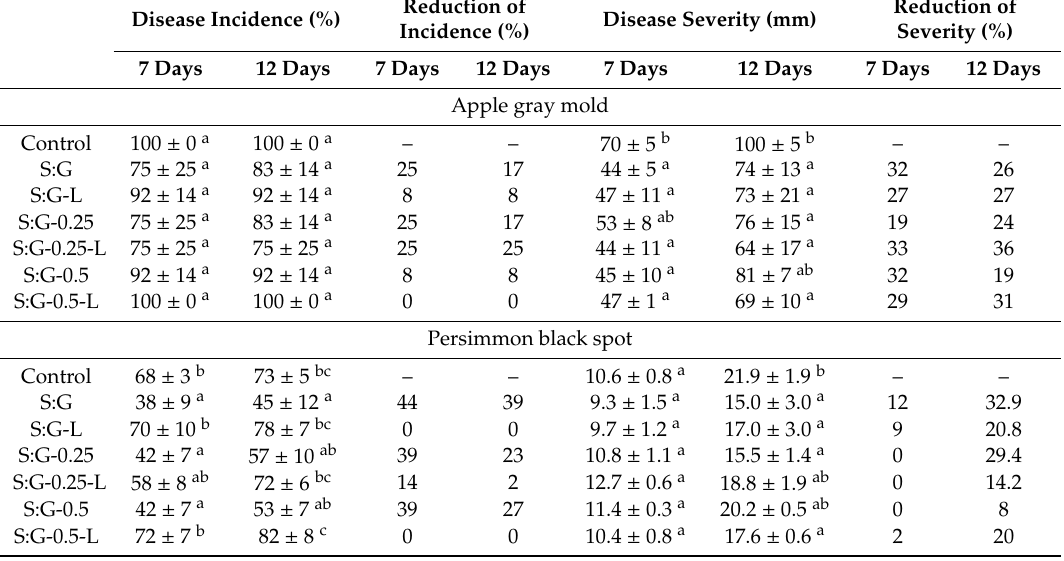
Table 5. Mean values and standard deviations of disease incidence and severity of gray mold on ‘Golden Delicious’ apples artificially inoculated with Botrytis cinerea and black spot on ‘Rojo Brillante’ persimmons artificially inoculated with Alternaria alternata . Fruit were coated 24 h after fungal inoculation and incubated at 20 ◦ C and 85% RH for 7 and 12 days. Mean values of the reduction in disease incidence and severity are also